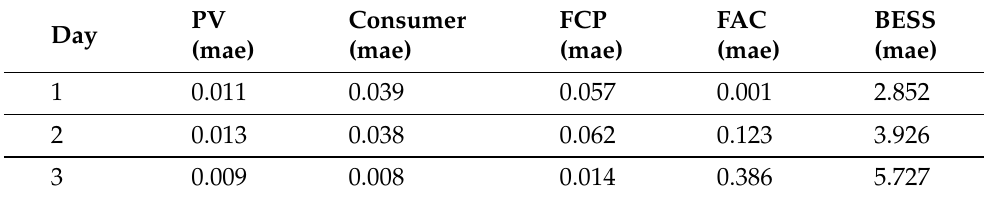
Table 6. Single-day training evaluation with benchmark solutions from the linear